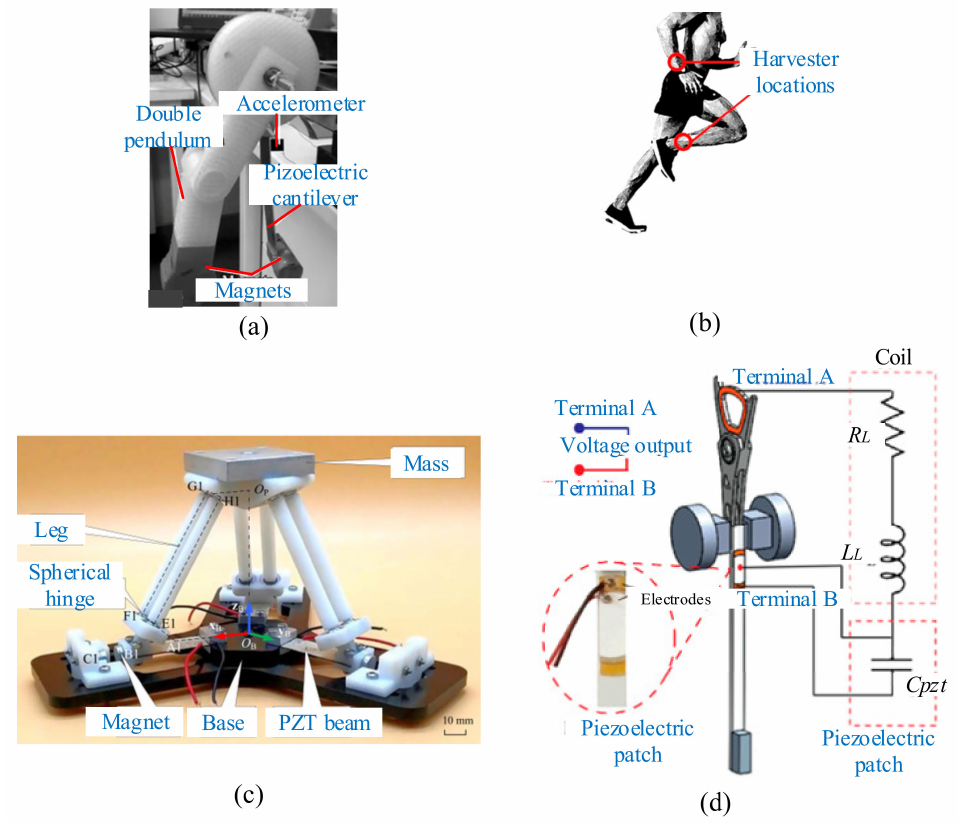
Figure 20. Representative design in applications. ( a ) A double-pendulum system (reproduced with permission from [223]; published by Elsevier, 2019). ( b ) Practical tests on a human leg and arm (reproduced with permission from [223]; published by Elsevier, 2019). ( c ) An arbitrary-directional harvester (reproduced with permission from [227]; published by IOP, 2019). ( d ) The hybrid harvester (reproduced with permission from [229]; published by MDPI,